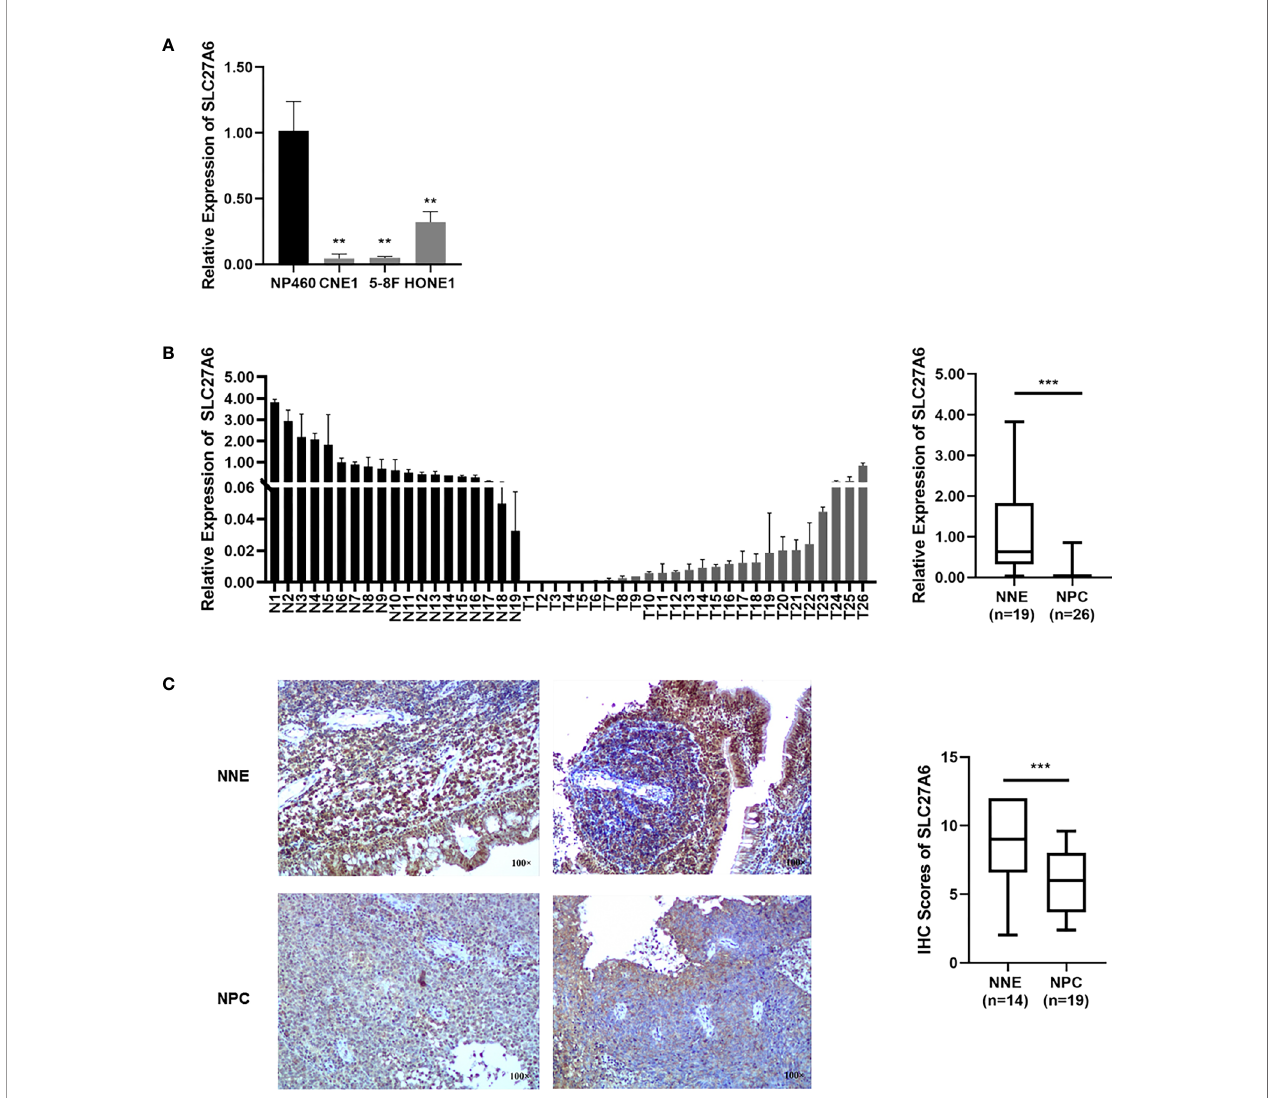
FIGURE 1 | The SLC27A6 expression is decreased in NPC. (A) SLC27A6 mRNA expression was tested by qRT-PCR in NPC cell lines (CNE1, 5-8F, and HONE1) and an immortalized epithelial (NP460) cell line. (B) SLC27A6 mRNA expression in primary NPC tissues (n=26) and NNE (n=19) specimens. (C) IHC staining of SLC27A6 in primary NPC tissues (n=19) and NNE (n=14) specimens. Magni fi cations ×100. ** P < 0.01 and *** P <